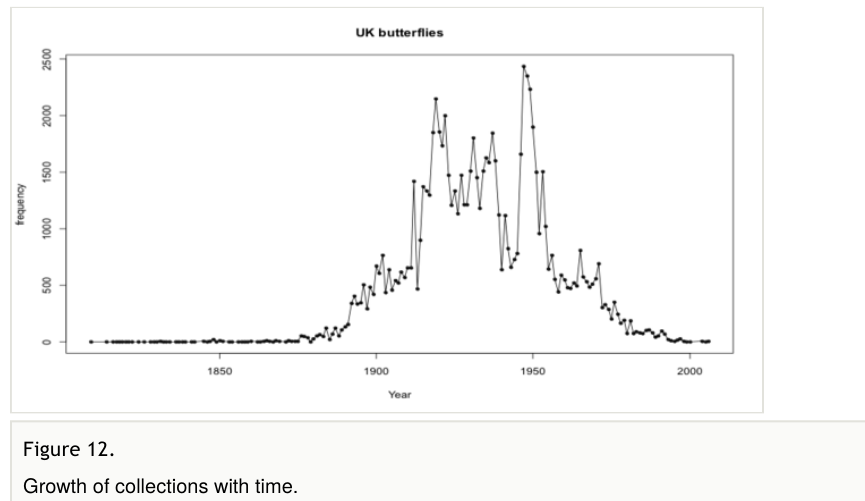
Growth of collections with